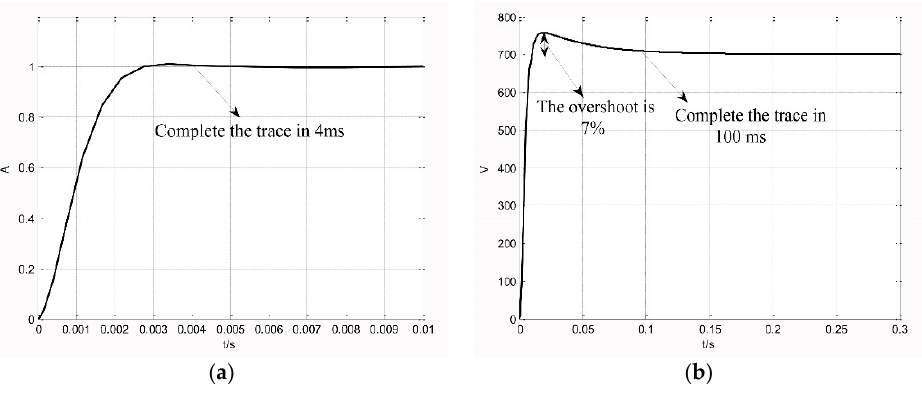
Figure 11. ( a ) Unit step response of current loop; ( b ) unit step response of voltage loop.